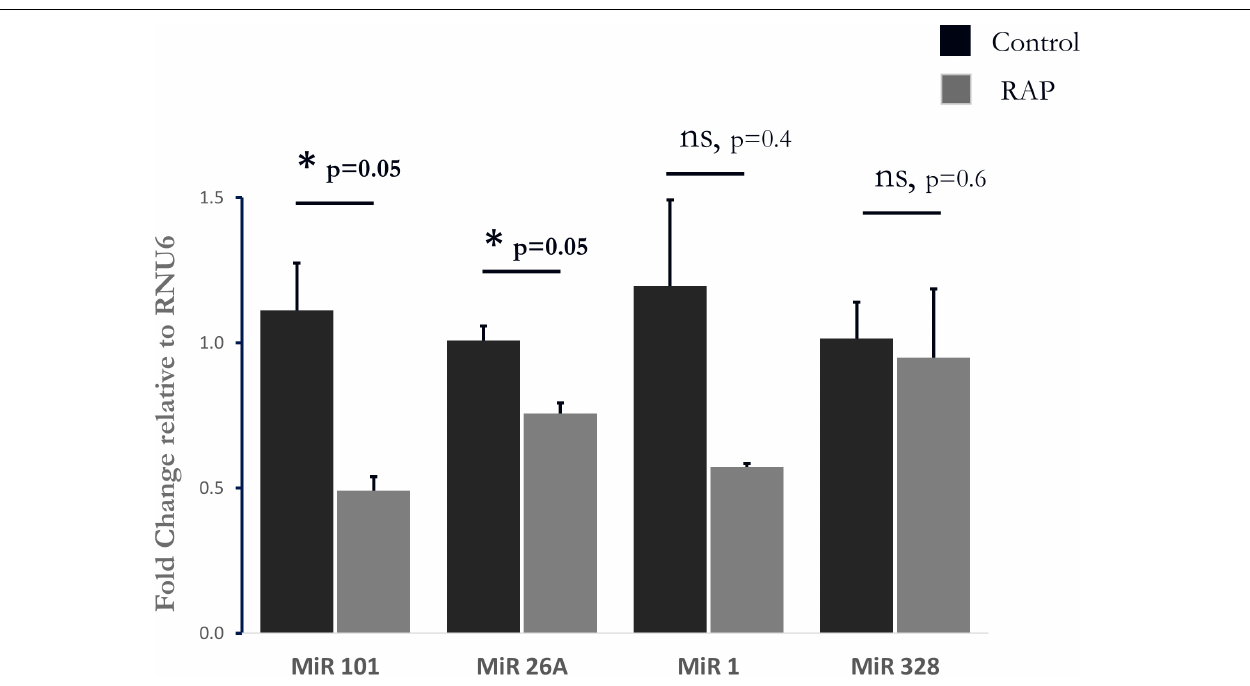
FIGURE 5 | Analysis of four Micro RNAs known to be involved in AF-related remodeling. Note significant downregulation of MIR-101, and MIR-26A as well as a non-significant tendency of reduction in MIR-1. MIR-328 was unaffected by RAP ( n = 3 for both RAP and control pacing, Mahan–Whitney test).